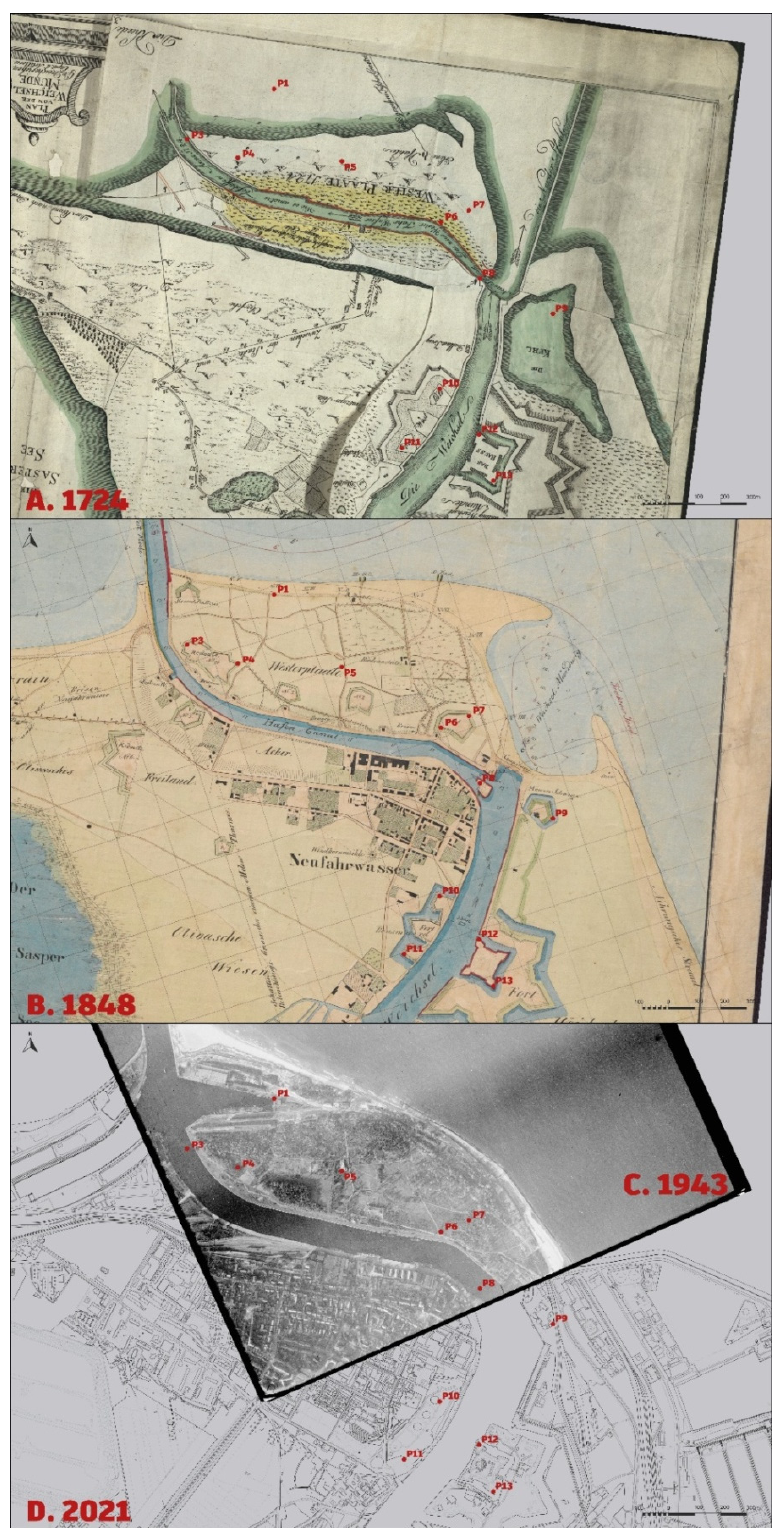
Figure 2. Methods of interpolating and calibrating the historical sources: ( A ) hand-drawn map from 1724; ( B ) printed geodesic map from 1848; ( C )aerial photo from 1943; ( D )modern CAD map.